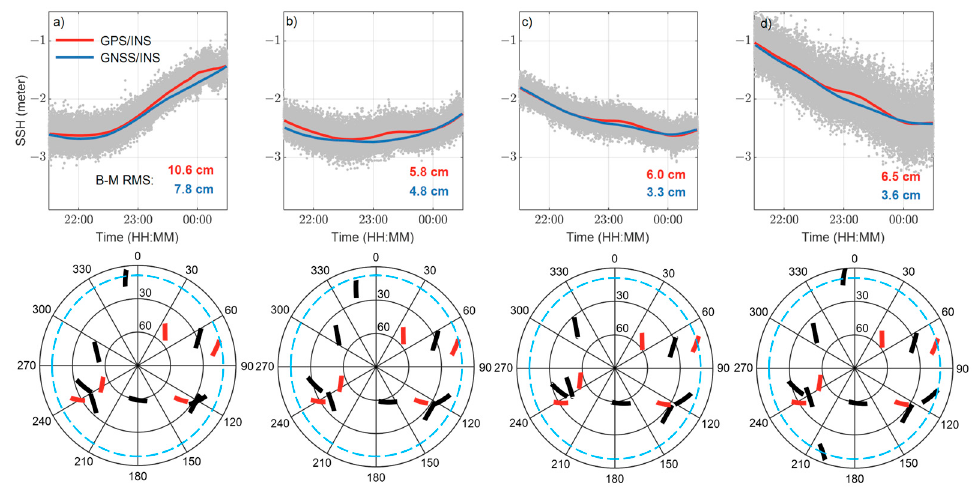
Figure 3. Comparison between GPS/INS and GNSS/INS SSH solutions. The upper four panels ( a – d ) show spurious biases in GPS/INS solutions (red smooth line) in comparison with a more reliable GNSS/INS solutions (blue smooth line). The four solution windows are centred around midnight over consecutive days in the same deployment (#66). The grey dots in the background are raw 2-Hz SSH, indicating information of the sea state for each time span. The RMS of the buoy-minus-mooring residuals over the selected windows are at the bottom right corner of the top panels, respectively for GPS/INS (red) and GNSS/INS (blue). The lower four panels present the sky plots of satellites in azimuth and elevation from GPS (red) and GLONASS (black) constellations observed by the buoy. The light blue dash line indicates the cut-off 10° elevation.